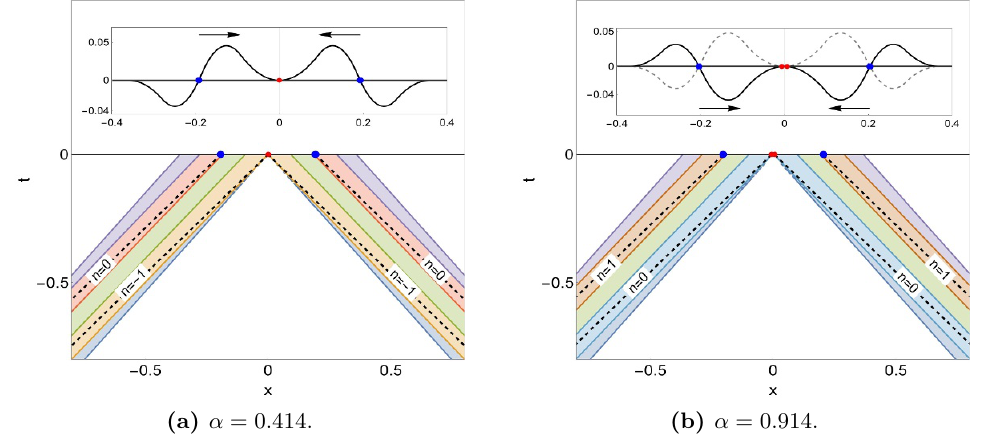
(a) (cid:11) = 0 : 414. (b) (cid:11) = 0 : 914. Figure 23 . Initial pro(cid:12)le of the signum-Gordon (cid:12)eld and worldsheets of the incoming oscillons for V = 0 : 93, v = 0 and (a) (cid:11) = 0 : 414, (b) (cid:11) = 0 : 914. The zeros are marked by dashed lines. Theirs positions at t = 0 are given by (a) B ( (cid:0) 1) ( (cid:11) ) = (cid:0) 0 : 006, B (0) ( (cid:11) ) = (cid:0) 0 : 204 and (b) B (0) ( (cid:11) ) = (cid:0) 0 : 006, B (1) ( (cid:11) ) = (cid:0) 0 :